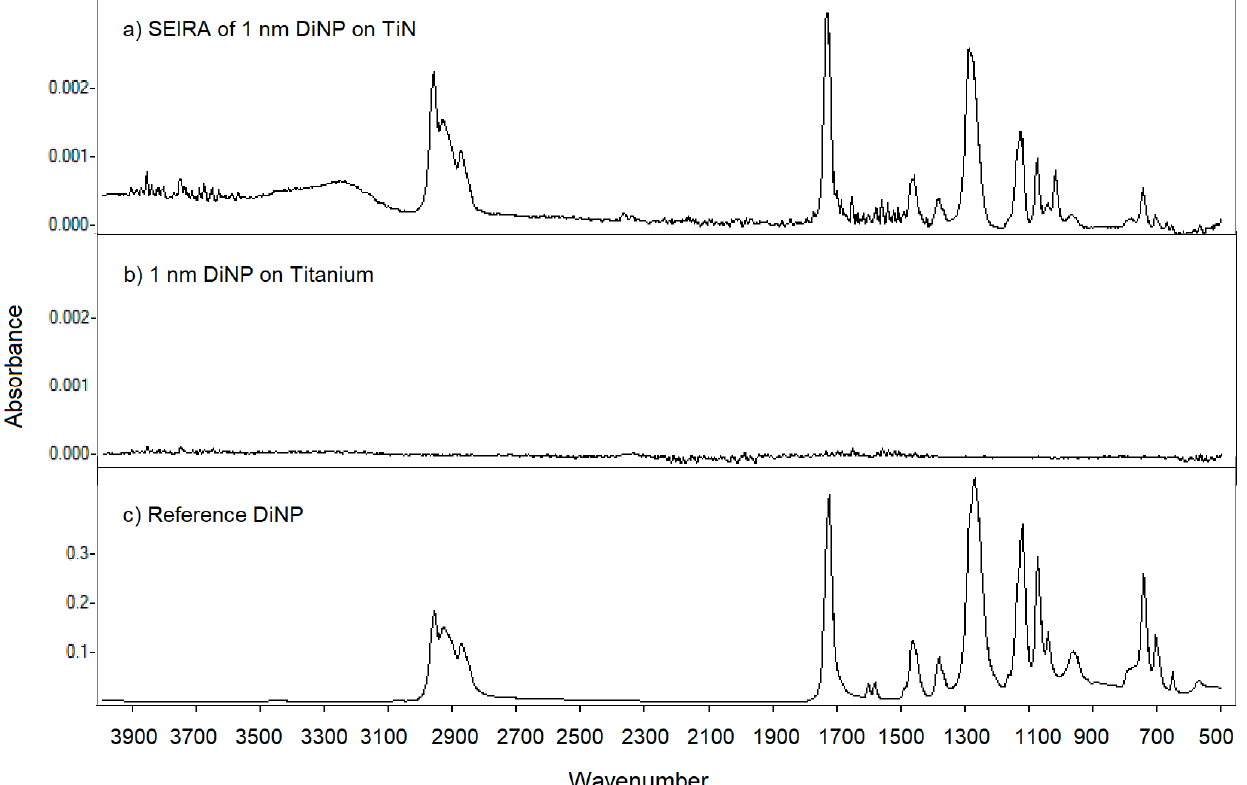
Figure 3. Raman Spectrum of TiN formed by MSN on Ti metal with the vibrational modes indicated.